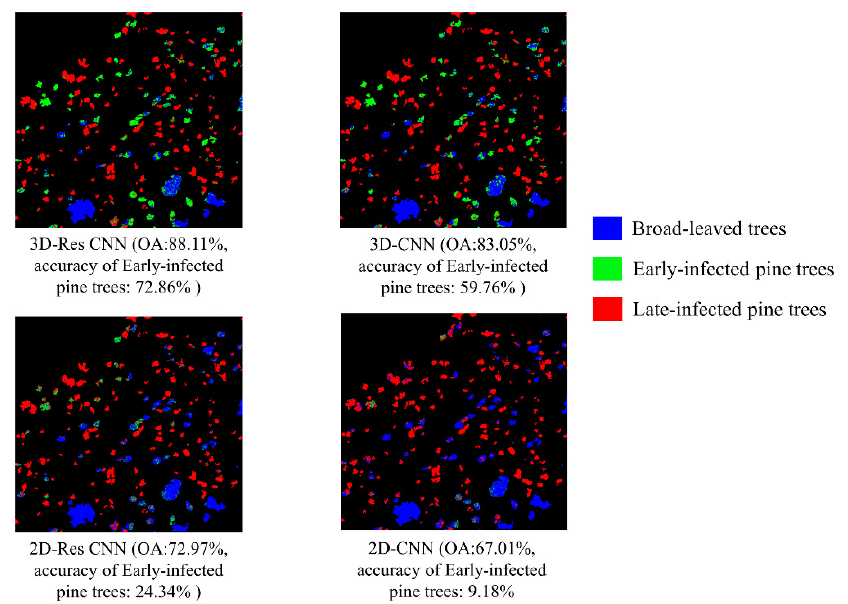
Figure 12. The classification results of three tree categories in the study area using the four models.